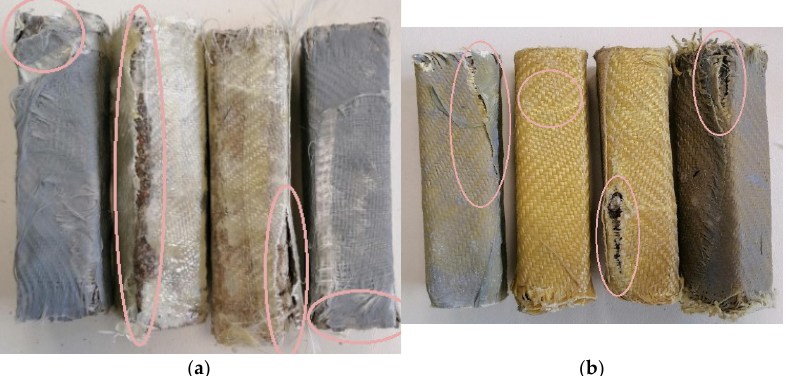
Figure 17. Compressed specimens reinforced with glass fiber fabric and Kevlar: ( a ) glass fiber ( b ) Kevlar fabric.